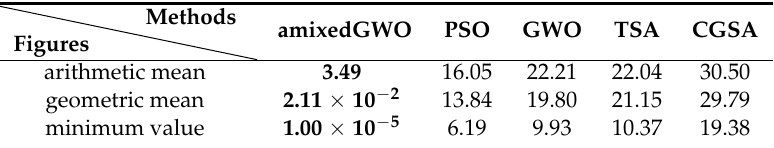
Table 4. Relevant figures computed over all experiments for all comparative methods on the obtained final scores: arithmetic mean, geometric mean, minimum